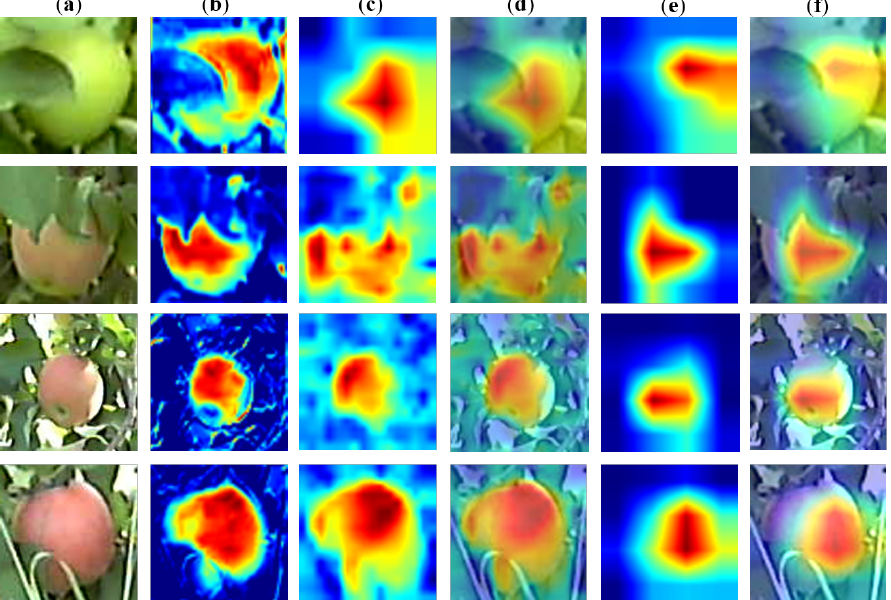
Figure 7. Visualizations of the feature map, highlighting the class-specific discriminative regions for the predicted examples from our proposed network. ( a ) Original four grades’ images from our test dataset. ( b ) Visualization feature map by our trained attention block. ( c , d ) Localization of class- discriminative regions by the CAM technique in our attention layer, overlapped with the original image. ( e , f ) Grad_CAM visualizations of our attention block and overlapped with the original image. Note that in ( c – f ), red regions correspond to high class